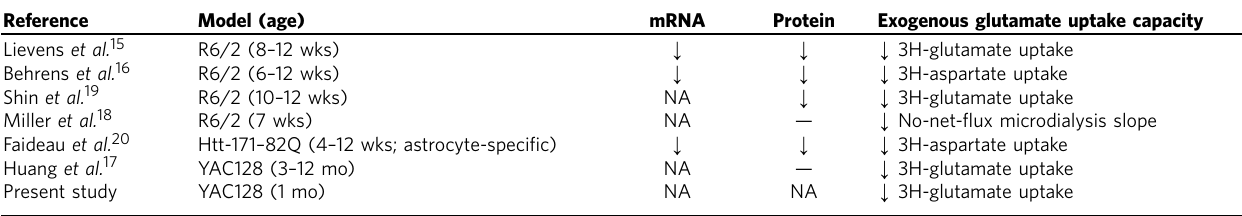
Table 1 | GLT-1 expression/function in